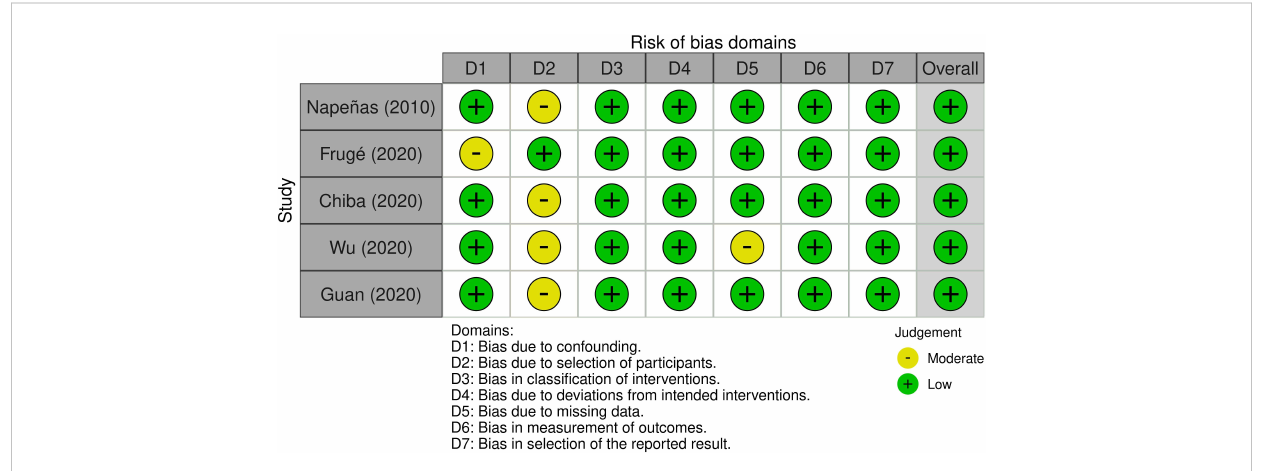
FIGURE 4 Risk of bias assessment for non-randomized intervention